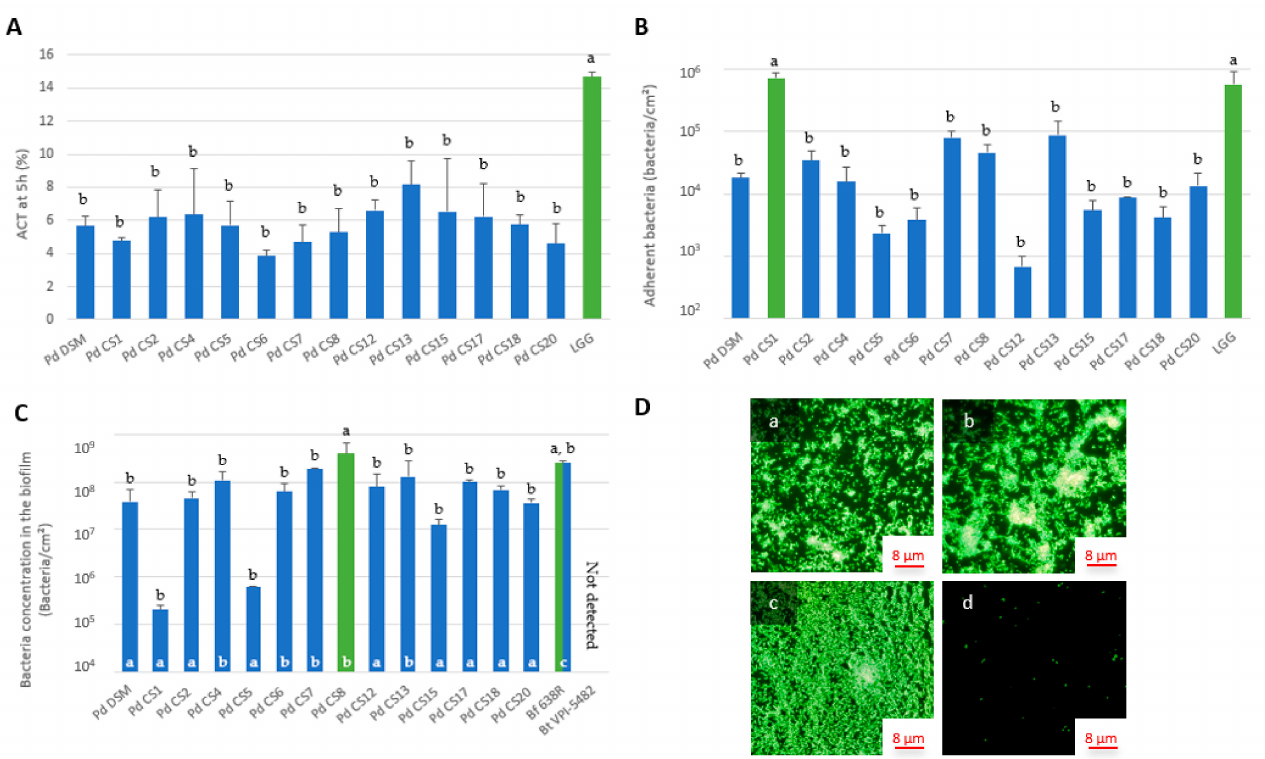
Figure 1. ( A ) Homo-aggregation coefficient (ACT) of 14 strains of P. distasonis and LGG (positive control) after 5 h of incubation at 37 ◦ C under anaerobic conditions. The colors coupled with a and b indicate the significantly different groups after ANOVA, p < 0.05. Error bars reflect standard error of the mean. ( B ) Adhesion capacity of 14 strains of P. distasonis and LGG (positive control) on abiotic support after 48h of incubation at 37 ◦ C under anaerobic conditions. The colors coupled with a and b indicate the significantly different groups after ANOVA, p < 0.05. Error bars reflect standard error of the mean. ( C ) Biofilm formation capacity of 14 strains of P. distasonis , Bf 638R (positive control) and Bt VPI-5482 (negative control) on abiotic support after 6 days of incubation at 37 ◦ C under anaerobic conditions. The colors coupled with black a and b indicate the significantly different groups based on ANOVA, p < 0.05. White a, b, and c indicate the biofilm organization pictures collected in ( D ). Error bars reflect standard error of the mean. ( D ) Biofilm organization on abiotic support after 6 days. ( a ) Organization showing small clusters of bacteria from P. distasonis CS2 biofilm; ( b ) Organization showing large clusters of bacteria from P. distasonis CS7 biofilm; ( c ) Biofilm formed by the positive control Bf 638R; ( d ) Scattered cells from the negative control Bt VPI-5482. All the data represent mean ± standard error or observations from at least two independent experiments performed with each strain in triplicate (n = 2 ×